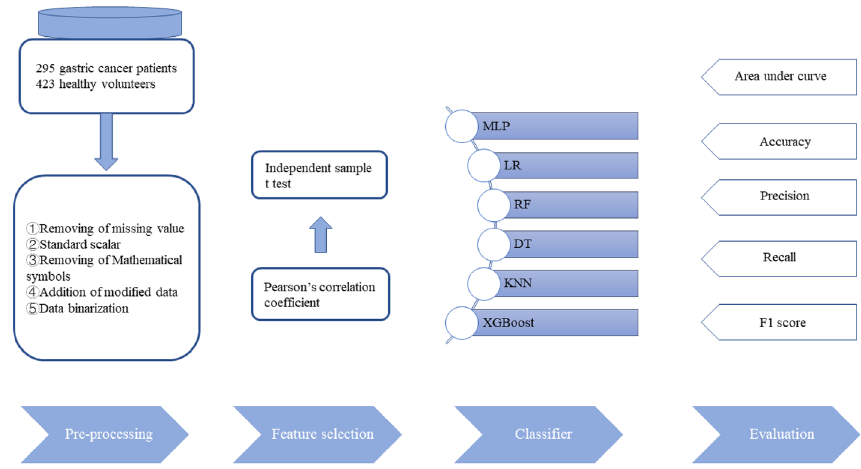
Figure 1. The roadmap of the proposed system based on the CRISP